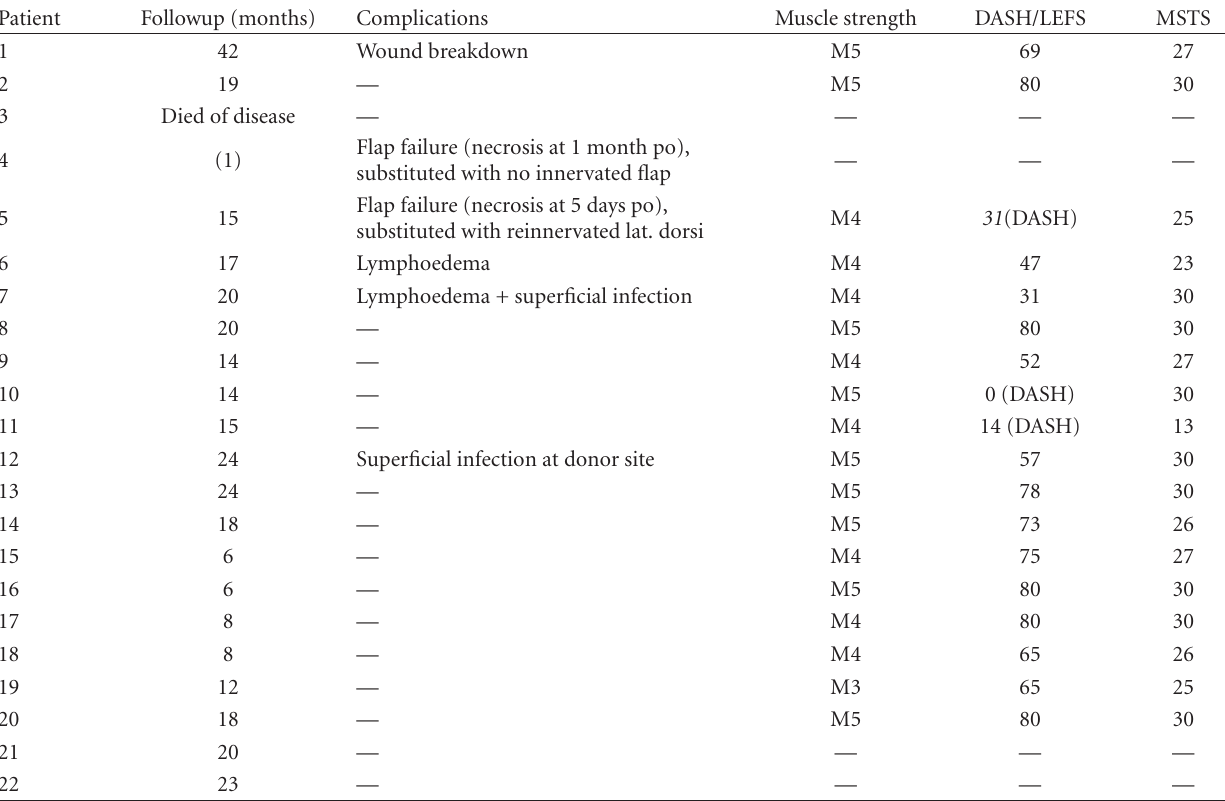
Table 2: Outcome of the innervated